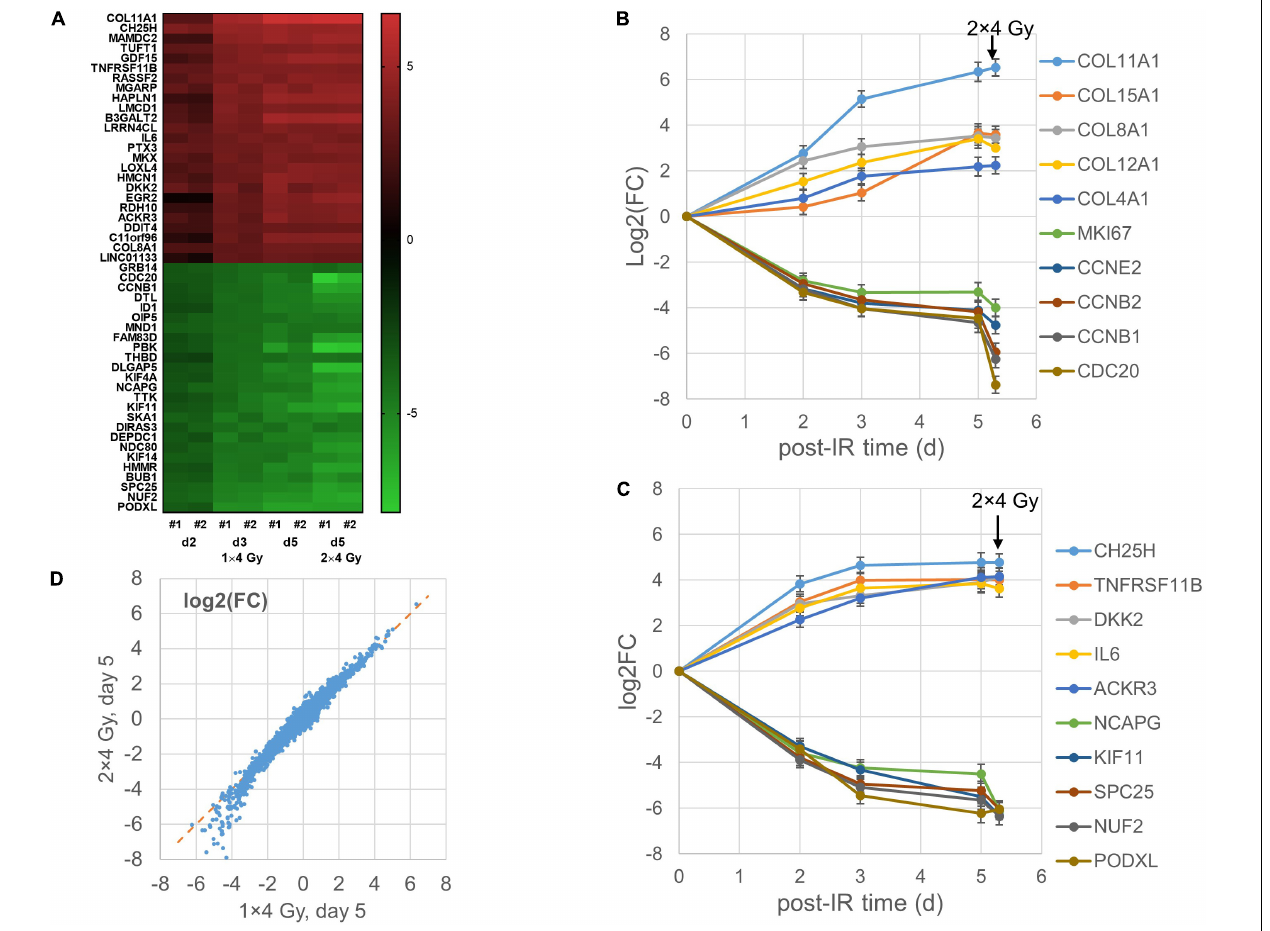
FIGURE 2 | Heat map of top 25 up- and down-regulated genes for the MA protocol in independent replicate microarray experiments #1–2 (A) . Examples of log2 fold changes [log2(FC)] in expression of differentially regulated genes 2–5 days after a single dose of 4 Gy or 5 days after the first of two fractions of 4 Gy; mean values and error bars (95% confidence intervals) from the two experiments are shown (B,C) . Correlation between mean log2(FC) values after 2 × 4 Gy and 1 × 4 Gy (D) with RNA isolation on day 5 after the first